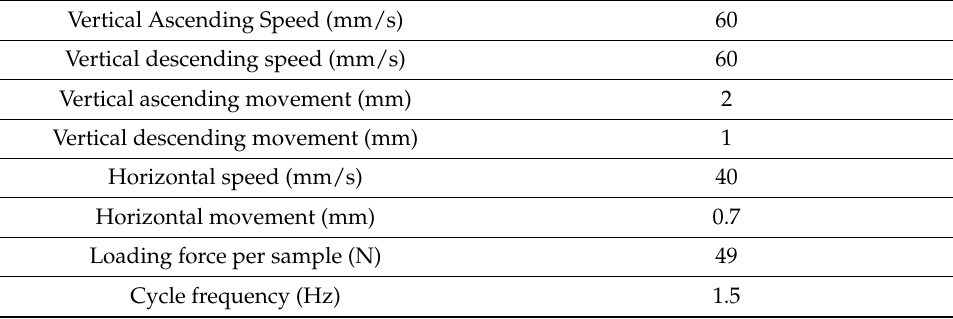
Table 1. Testing parameters for chewing